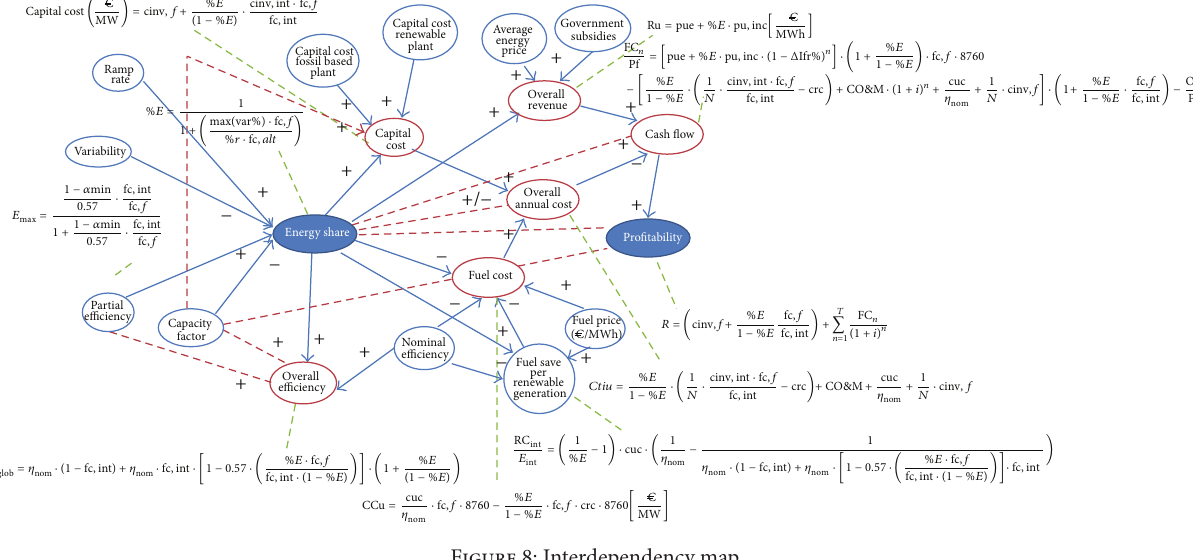
Figure 8: Interdependency map.